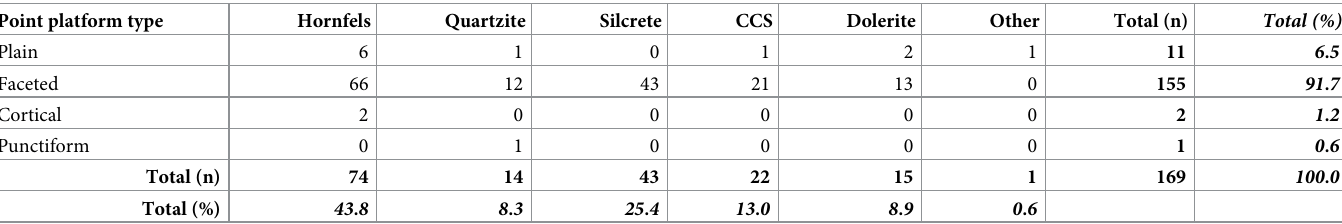
Table 9. Frequencies of point platform types by raw